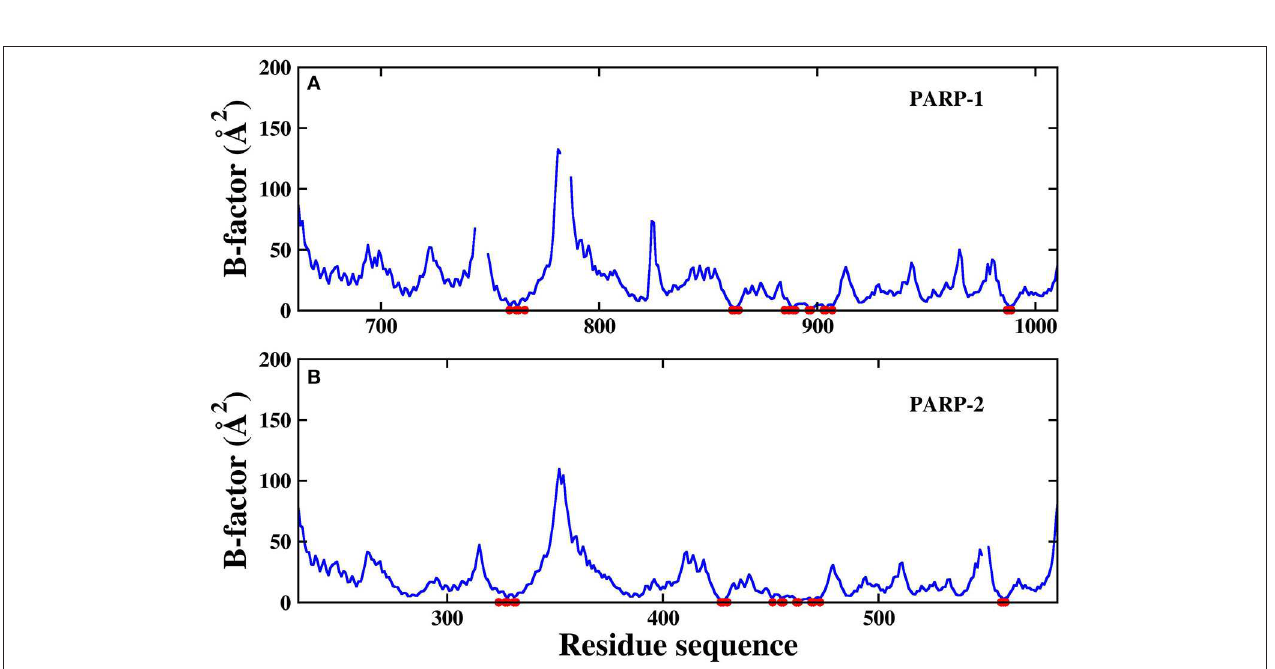
FIGURE 4 | The calculated B-factor of protein C α atoms in the simulations. The residues in the pocket are marked with red circle. (A) PARP-1 (B) PARP-2.